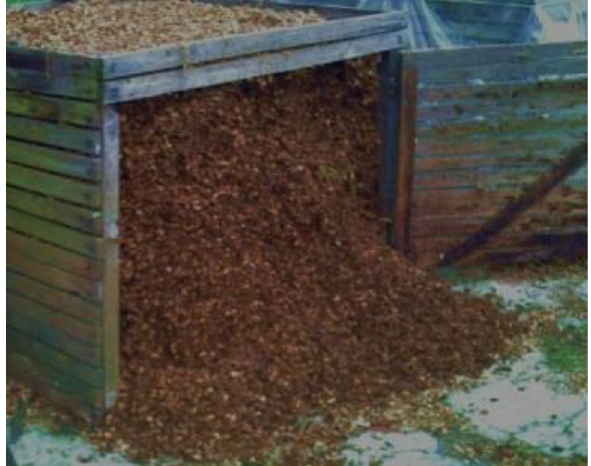
Fig. 2 Provided peanut shells + Azolla